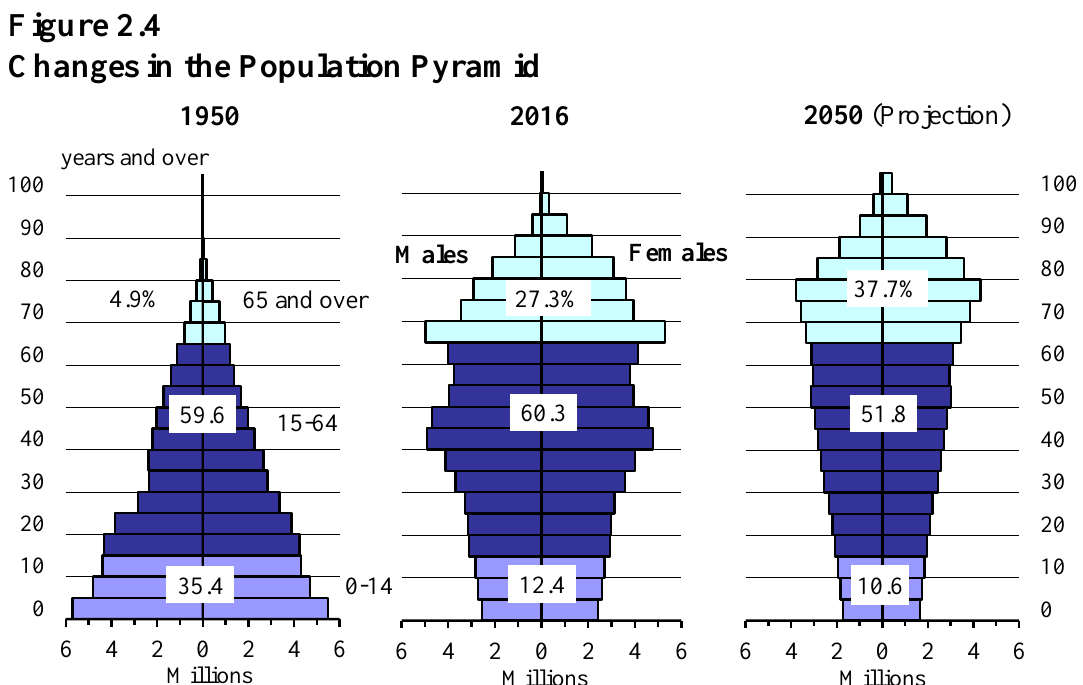
Changes in the Population